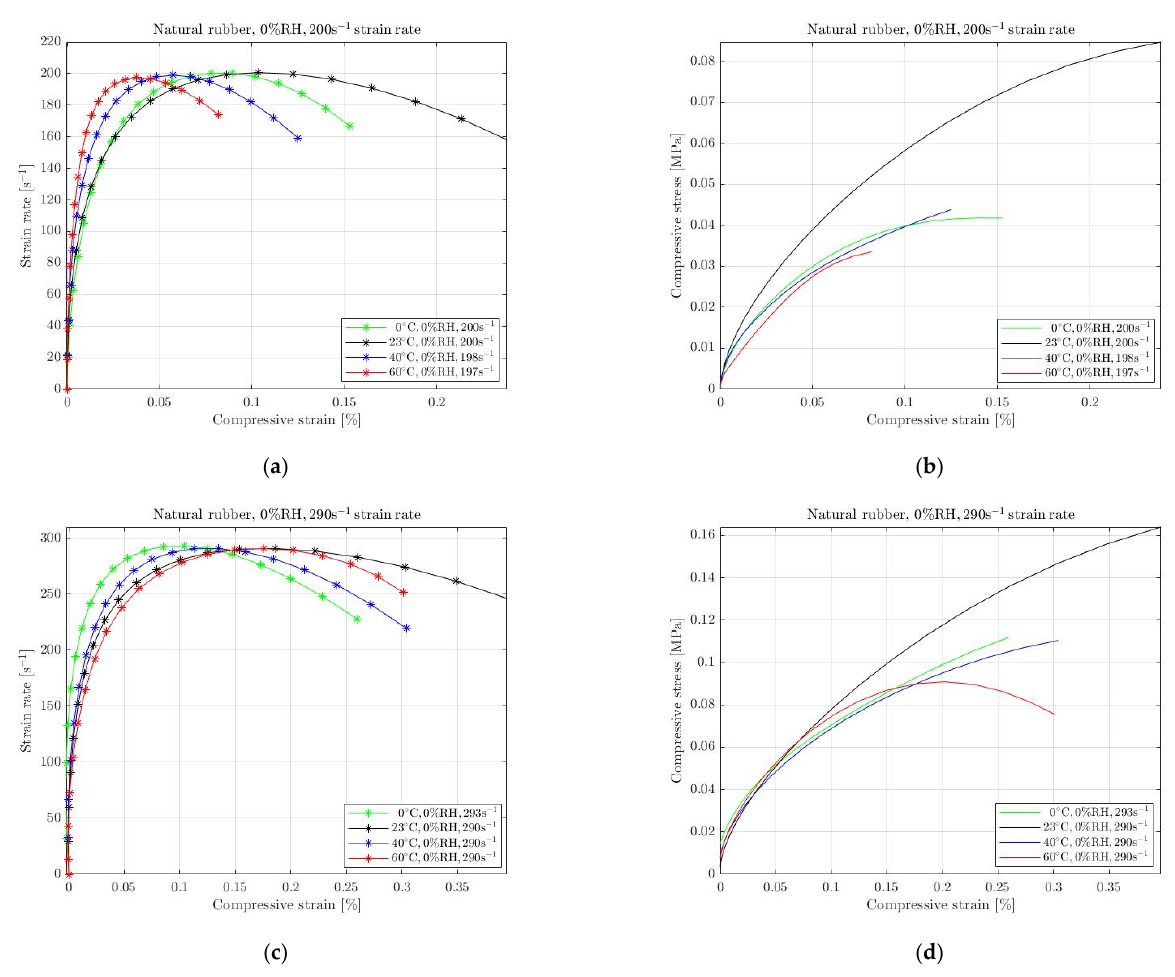
Figure 5. Strain rate vs. compressive strain ( a , c ) and compressive stress vs. compressive strain ( b , d ) of natural rubber at 0 °C, 23 °C, 40 °C and 60 °C temperature with 0% RH for 200 s − 1 ( a , b ) and 290 s − 1 ( c , d ) strain rate.